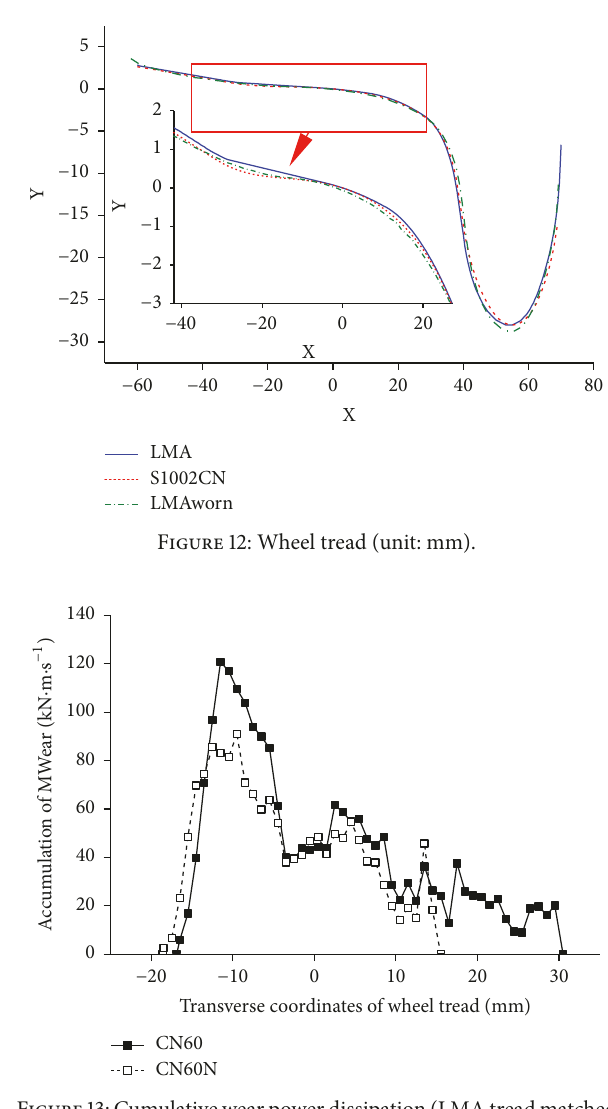
Figure 13: Cumulative wear power dissipation (LMA tread matched with the different rail